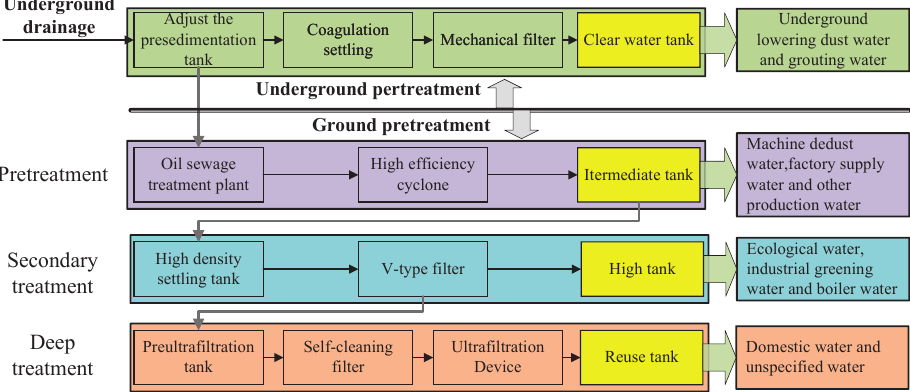
Figure 1. Mine water process flow with graded and fractionated